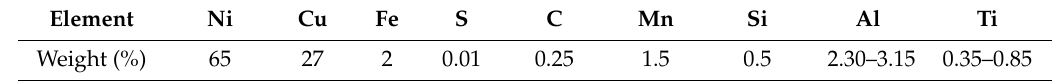
Table 1. Chemical characteristics of Monel